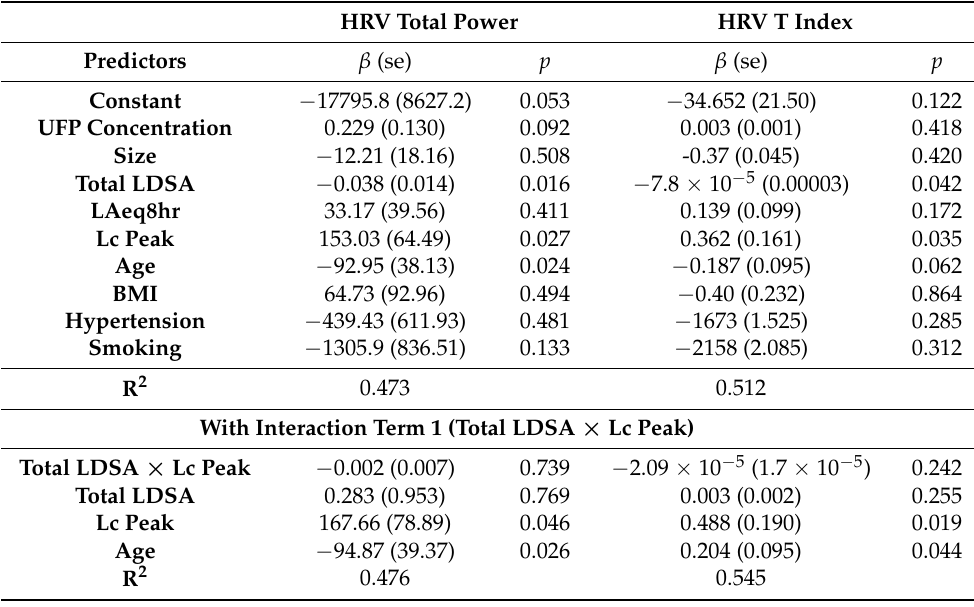
Table 4. Multiple linear regression model to predict HRV Total Power and HRV Triangular index (T-index) as a function of UFP and noise exposure parameters, and of personal and lifestyle